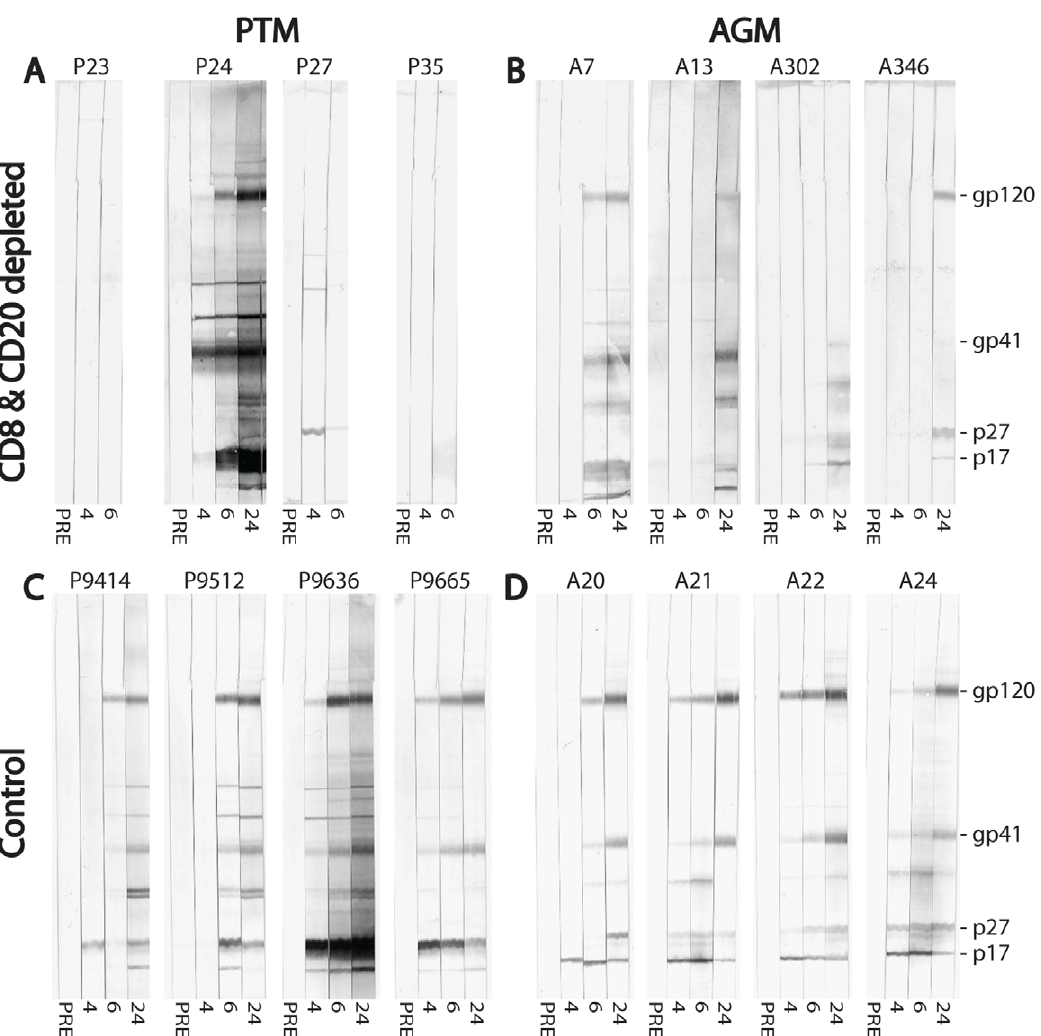
Figure 10. Impairment of SIV agm -specific antibodies in CD8 + and CD20 + lymphocyte-depleted vervet AGM and PTM. Development of SIV agm -specific antibody responses by Western blot analysis is shown for CD8 + and CD20 + lymphocyte-depleted vervet AGM ( A ) and PTM ( B ) in the top row. The bottom row shows historic SIV agm -infected vervet AGM ( C ) and PTM ( D ) as controls. Numbers below the strips indicate time in weeks following SIV agmVer90 infection. The location of the major SIV proteins is shown on the right.